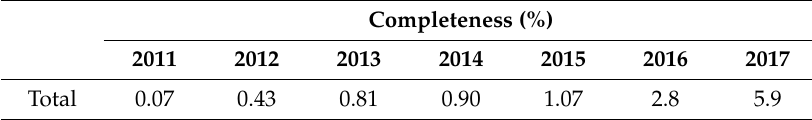
Table 5. OSM datasets completeness.